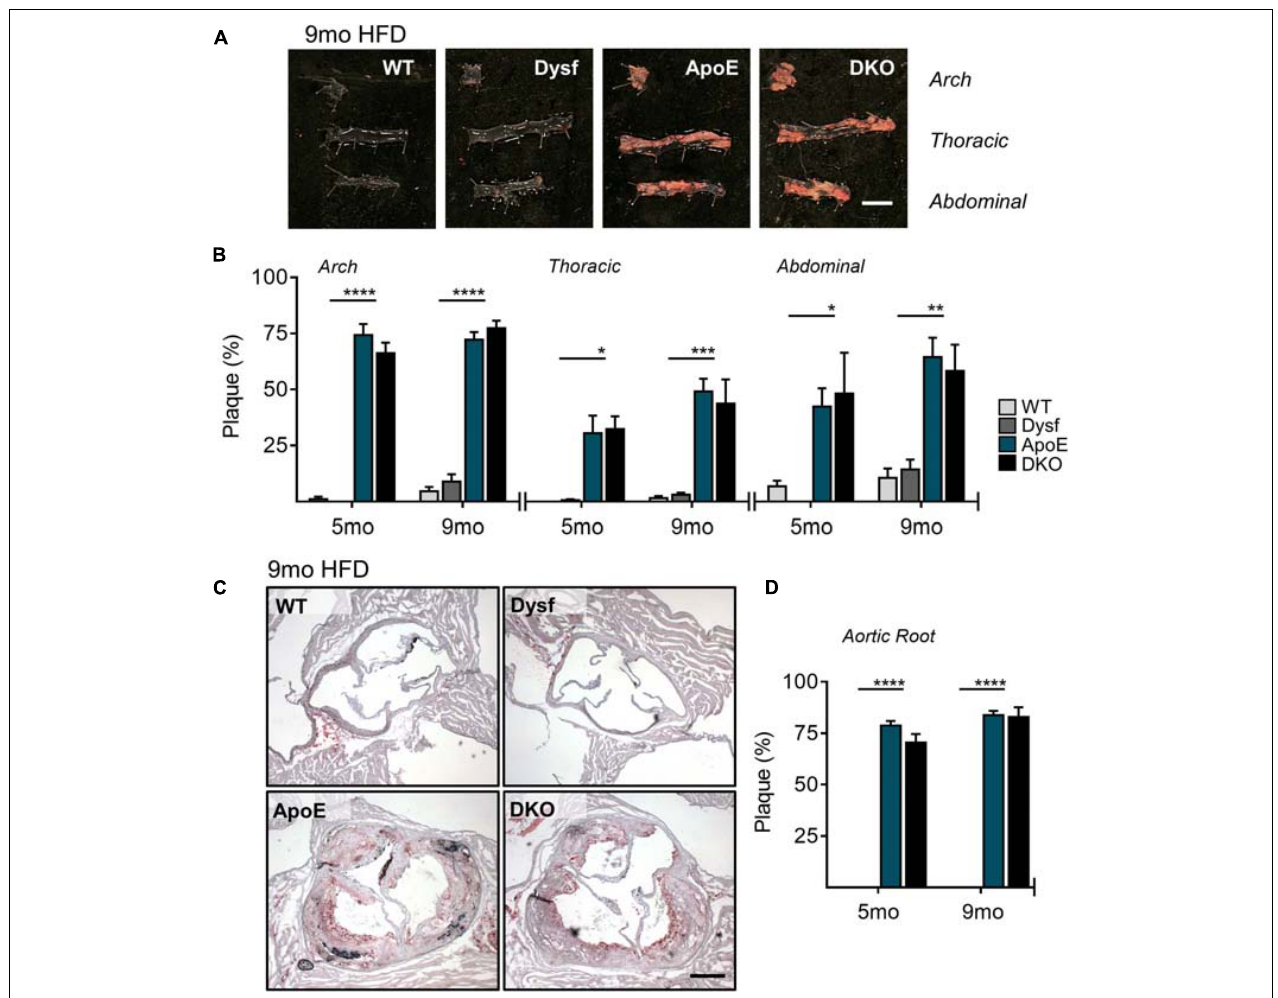
FIGURE 2 | Similar atherosclerotic plaque accumulation in aortic segments from ApoE and DKO mice after 5 and 9 months (mo) of HFD-feeding. (A) Representative images of Sudan IV stained plaque accumulation in distal, arch, thoracic, and abdominal aortic segments from WT, Dysf, ApoE, and DKO mice after 9 months of HFD-feeding, and quantification of plaque accumulation after both 5 and 9 months of HFD-feeding (B) , 5 months: WT ( N = 5), Dysf ( N = 5), ApoE ( N = 6), and DKO ( N = 4), 9 months: WT ( N = 6), Dysf ( N = 6), ApoE ( N = 5), and DKO ( N = 7). Mean + SEM. WT and Dysf genotypes significantly different from ApoE and DKO at each time-point; P < 0.05 (*); P < 0.01 (**); P < 0.001 (***); P < 0.0001 (****); two-way ANOVA with Sidak’s post hoc tests. No significance changes to atherosclerosis was detected between 5 and 9 months-fed cohorts; two way ANOVA. Scale bar = 0.5 cm. Similar atherosclerotic plaque accumulation in the aortic sinus of ApoE and DKO mice after 5 and 9 months (mo) of HFD-feeding. (C) Representative images of Oil Red O stained plaque accumulation in the aortic root sinus of WT, Dysf, ApoE, and DKO mice after 9 months of HFD-feeding, and quantification of plaque accumulation after both 5 and 9 months of HFD-feeding (D) , 5 months: WT ( N = 7), Dysf ( N = 4), ApoE ( N = 6), and DKO ( N = 4), 9 months: WT ( N = 4), Dysf ( N = 5), ApoE ( N = 5), and DKO ( N = 6). Mean + SEM. WT and Dysf genotypes significantly different from ApoE and DKO; P < 0.0001 (****). Two-way ANOVA with Sidak’s post hoc tests. No significance changes to atherosclerosis was detected between 5 and 9 months-fed cohorts; two way ANOVA. Scale bar = 0.5 cm.